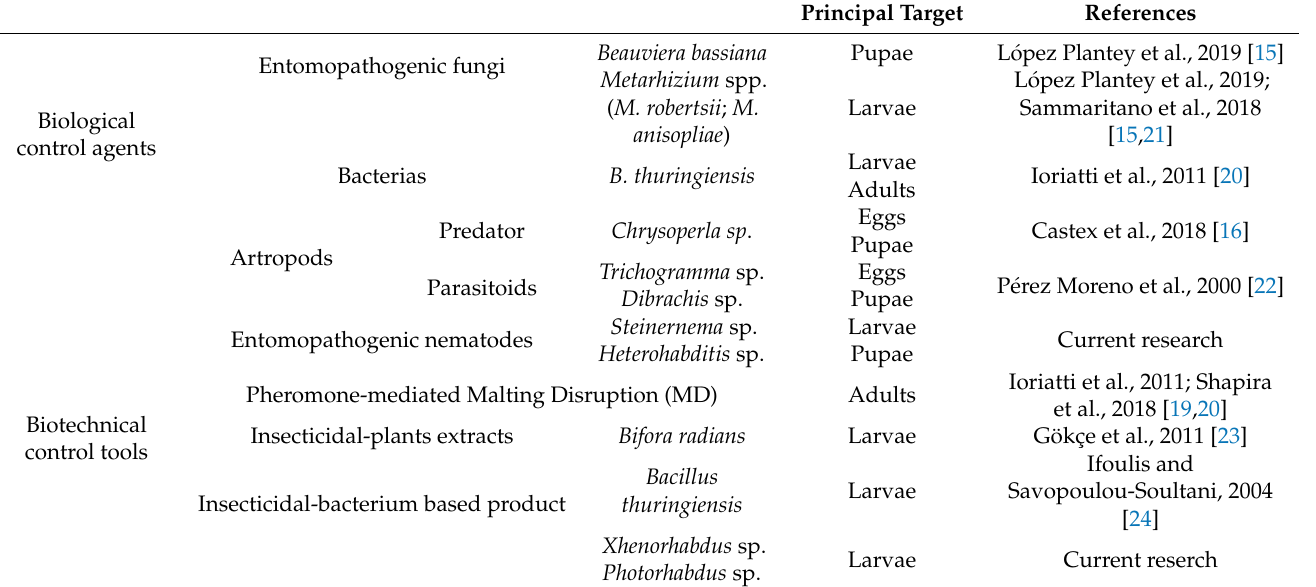
Table 1. Overview of biological control agents and biotechnical control tools against grapevine moths in viticulture and the facultative use of entomopathogenic nematodes and their symbiotic bacteria-based